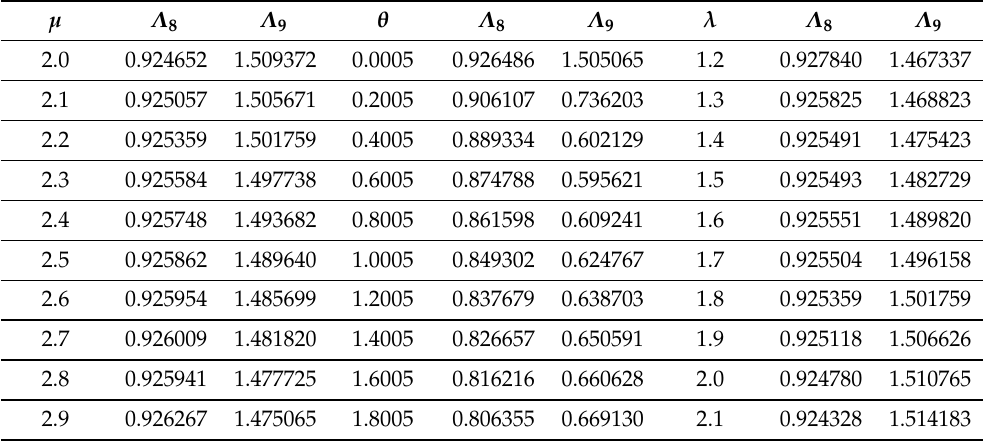
Table 8. Influence of λ , µ and θ on the fraction of successful rate of retrials and mean number of active servers for c = 2.